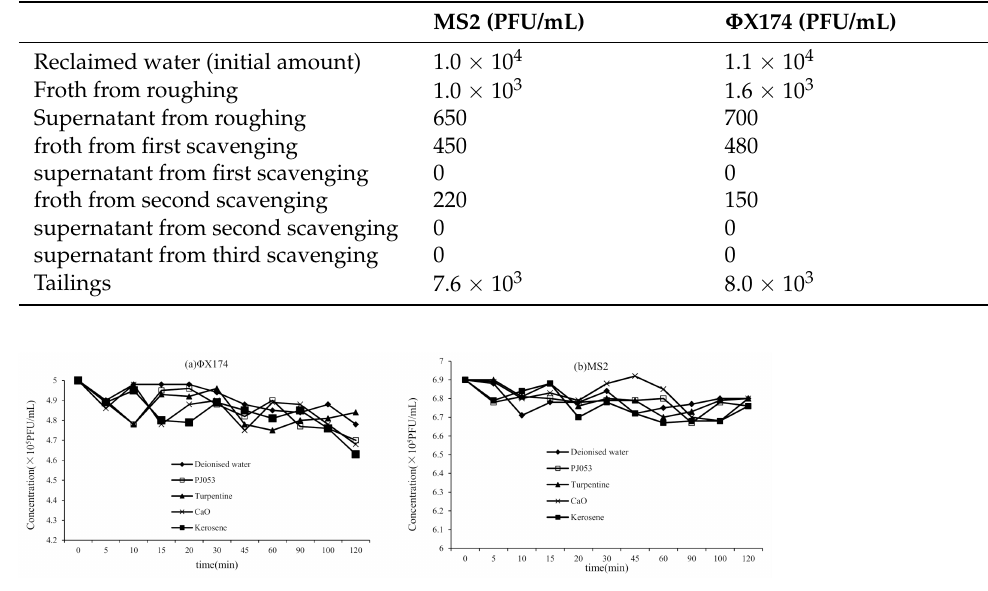
Figure 2. Effect of flotation reagents on the survival of ( a ) Φ X174 and ( b )